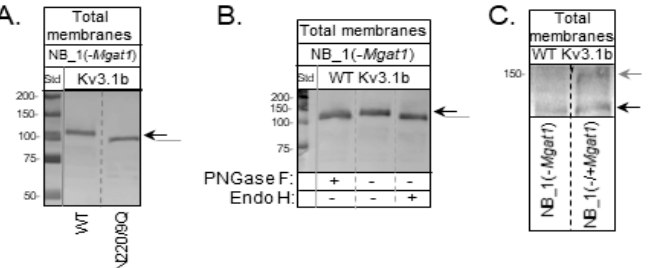
Figure 4. Immunoblot of Kv3.1b stable expressed in GnT-I knockout NB cells. ( A ) A Western blot of glycosylated (WT) and unglycosylated (N220/229Q) Kv3.1b proteins in total membranes from stably transfected NB_1(- Mgat1 ) cells. ( B ) A Western blot of total membrane proteins from NB_1(- Mgat1 ) cells stably expressing WT Kv3.1b digested (+) and undigested ( − ) with PNGase F and Endo H. ( C ) A Western blot of Kv3.1b from NB_1 ( − Mgat1 ) cells stably expressing WT Kv3.1b compared to those cells transiently transfected with GnT-I. Molecular weight standards in kDa: 250; 150; 100; 75; 50; and 37 from top to bottom. Black and grey arrows denote Kv3.1b glycoprotein with oligomannose and complex types of N-glycans, respectively. The grey line signifies unglycosylated Kv3.1 protein. See also Figures S6–S8.